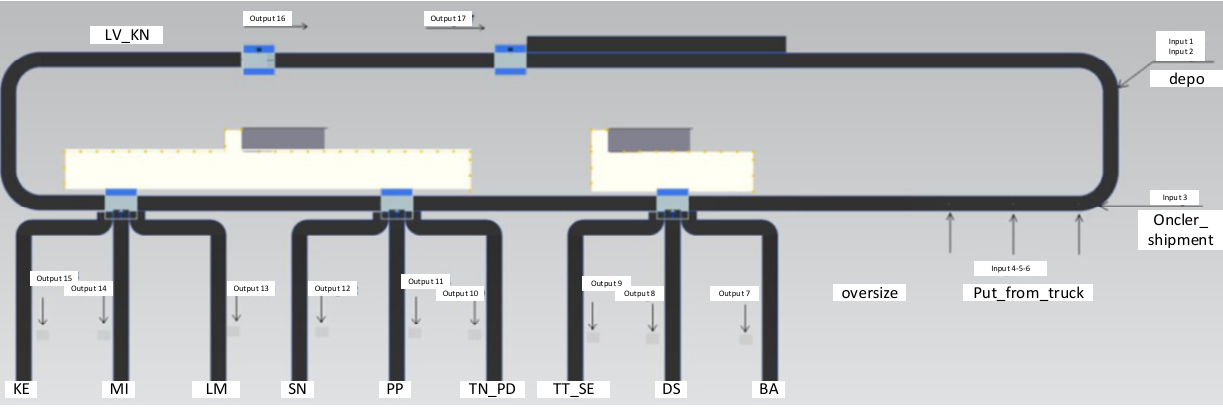
Figure 6. Conveyor system of sorting in the warehouse and